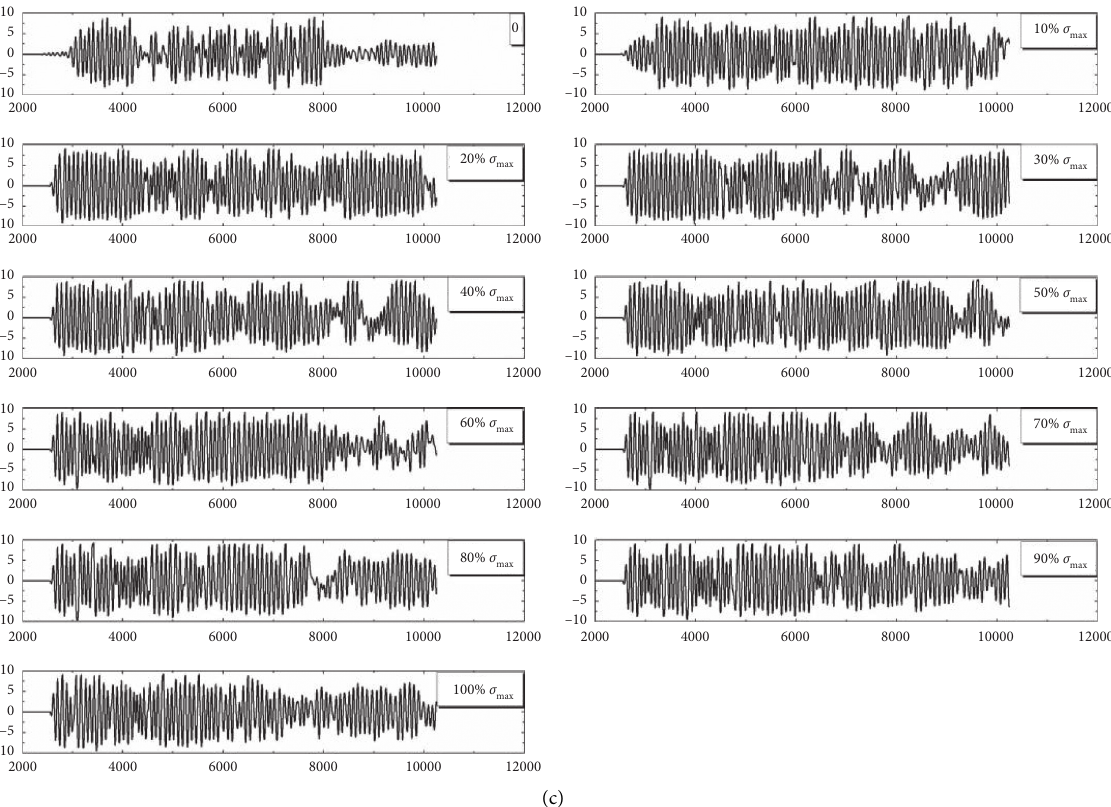
Figure 3: Receiving waveform at different stress stages. (a) X direction. (b) Y direction. (c) Z direction (the unit of abscissa is 10 − 7 s, and the unit of ordinate is